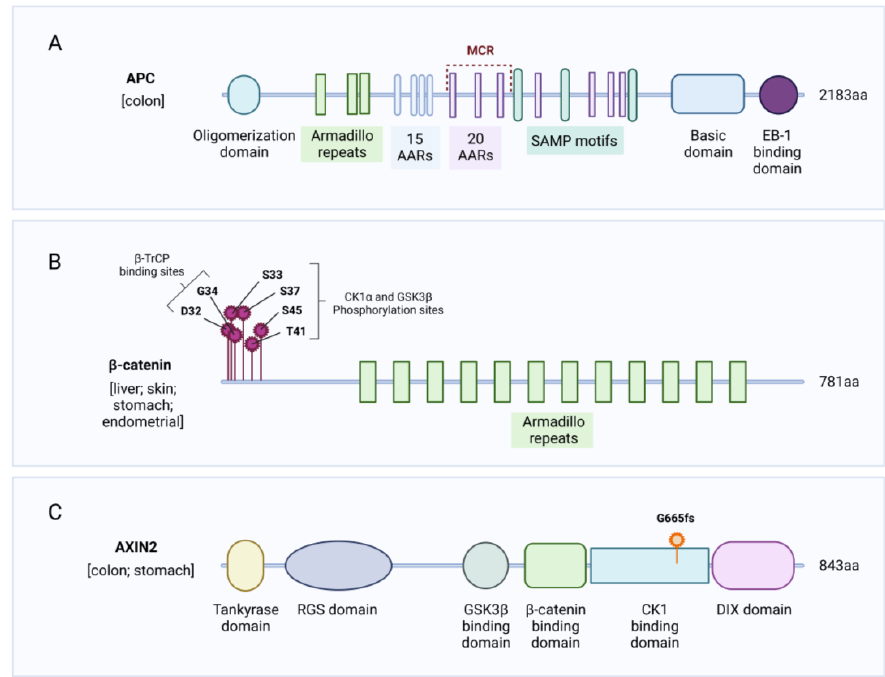
Figure 3. The impact of specific mutations in APC , CTNNB1, and AXIN2 on protein functionality in certain cancers. ( A ) Schematic representation of APC protein. 15AARs and 20AARs are required for -catenin binding, SAMP repeats bind to AXIN. MCR denotes the mutation cluster region of recur- rent APC mutations found in CRC — these mutations give rise to truncated proteins that lack the SAMP motifs and typically only retain between 1 and 3 intact 20AARs. Therefore, these truncated proteins have significantly reduced -catenin and AXIN binding capacity. ( B ) Schematic represen- tation of -catenin protein and recurrent exon 3 mutations found in liver, skin, endometrial, and stomach cancer. Ser33, Ser37, Thr41, and Ser45 are phosphorylated by CK1 and GSK3 marking - catenin for subsequent ubiquitination. Asp32 and Gly34 are required for correct -TrCP binding for -catenin to be ubiquitinated. Point mutations at these 6 amino acids result in the stabilization of - catenin in the cytoplasm. ( C ) Schematic representation of the AXIN2 protein and location of recur- rent frameshift mutation found in colon and stomach cancer. The recurring frameshift mutation at G665 lies within the CK1 binding domain of AXIN2. This mutation induces a truncation and therefore gives rise to a protein with impaired CK1 binding, disrupting the function of the destruction complex. Infor- mation on protein domain structures and mutation locations from cBioportal [30,31,38,39]. Figure created with BioRender.com